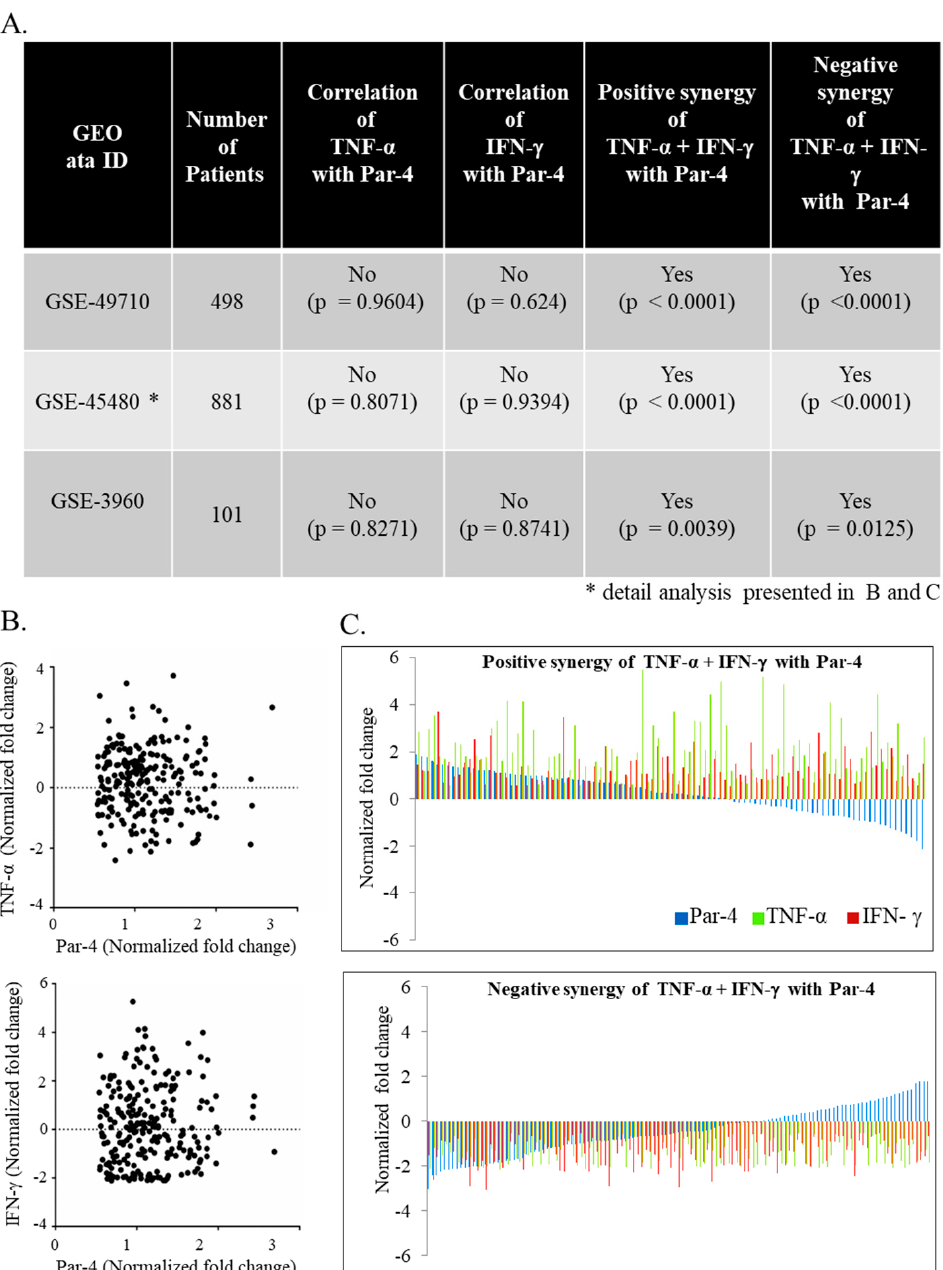
Figure 6. Correlative gene-expression profile of IFN- γ and TNF- α in relation with Par-4 of human neuroblastoma datasets. Three datasets from neuroblastoma patients were obtained from gene expression omnibus (GEO) database ( A ) We evaluated the individual correlation between Par-4 with IFN- γ or TNF- α and significance value described for one dataset; ( B ) positive (upper panel; also upper panel in ( C )); and negative (lower panel; also lower panel in ( C )) synergies were determined in the datasets by determining the correlation between differentially regulated Par-4 with IFN- γ and TNF- α together. GSE: GEO accession number; *: detail analysis presented in ( B , C ).